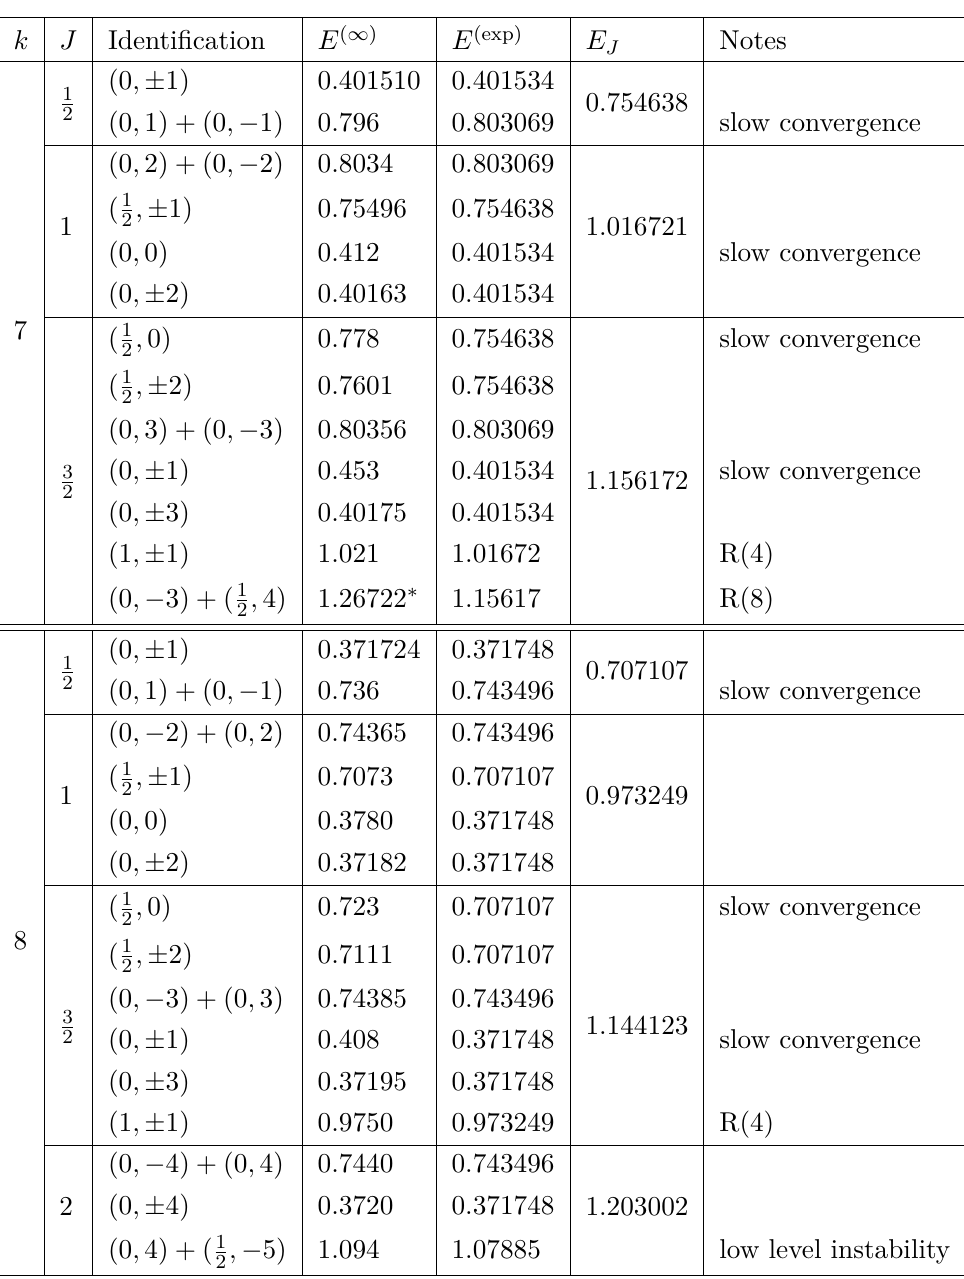
Table 11 . List of solutions in the SU(2) k WZW model with k ≤ 8 describing SU(2) Cardy boundary states, part 2. The table has the same format as table